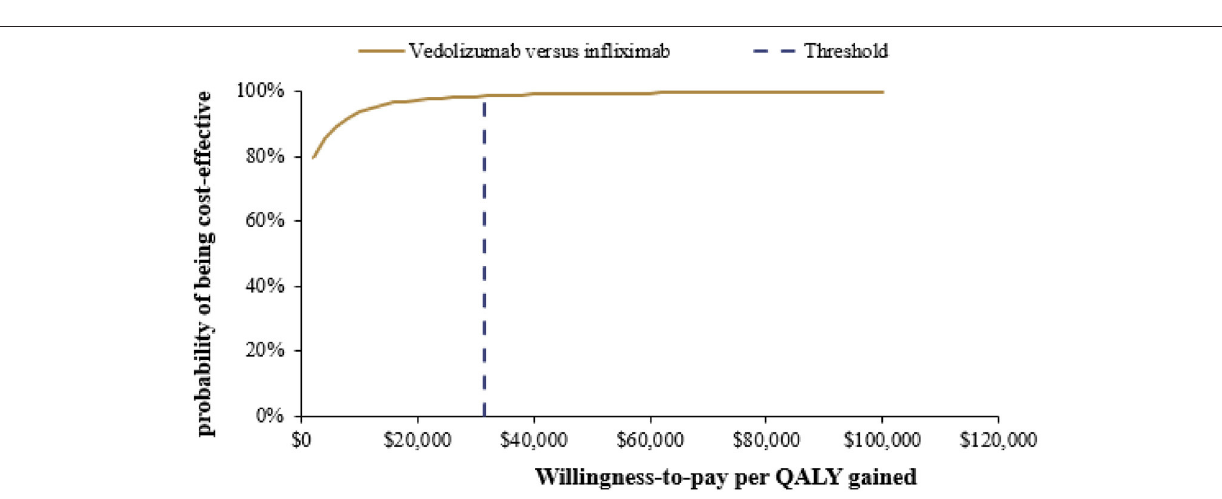
FIGURE 3 | Cost-effectiveness acceptability curve for vedolizumab vs. infliximab. QALY, Quality-adjusted